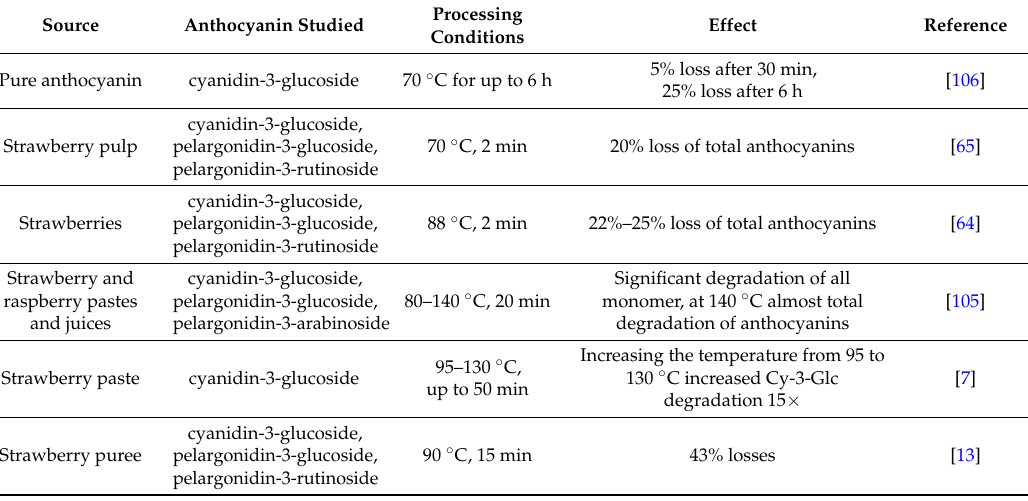
Table 3. Effect of thermal processing on the anthocyanins